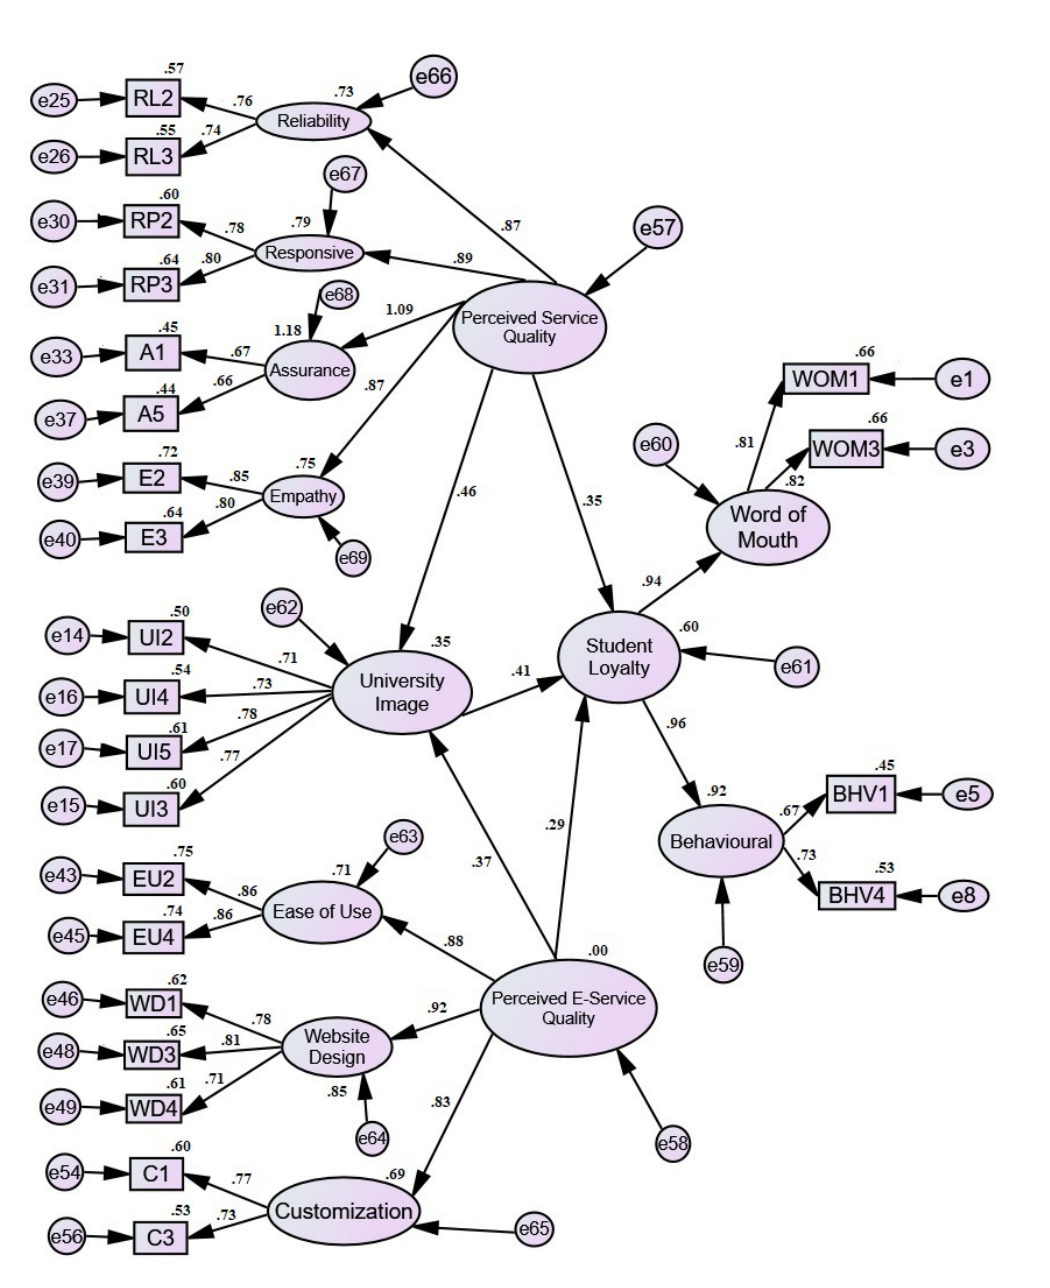
Figure 3 . Structural model. RL = reliability; RP = responsiveness; A = assurance; E = empathy; EU = ease of use; WD = website design; C = customization; WOM = word of mouth; BHV =